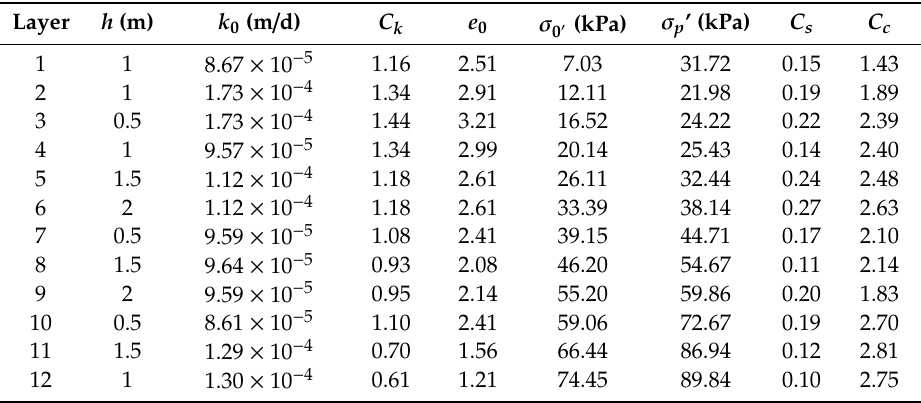
Figure 4. Comparisons of calculated and measured excess pore water pressure along time.